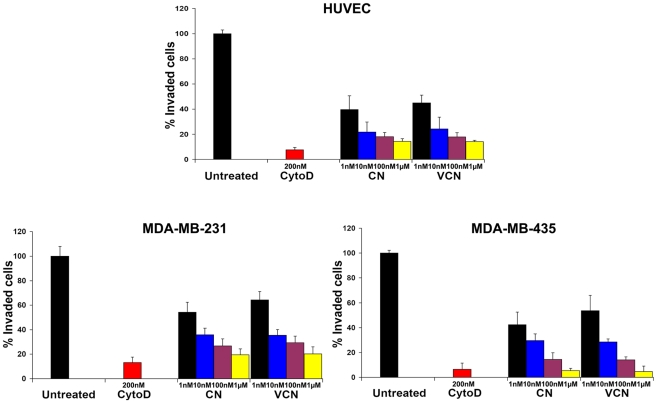
VCN inhibits cell invasion through a reconstituted basement membrane in a dose-dependent manner.The anti-invasive properties of VCN were tested in a modified Boyden chamber assay where serum-starved HUVEC, MDA-MB-231 or MDA-MB-435 cells were preincubated with various concentrations of disintegrins (1–1000 nM) for 10 min before being seeded into Matrigel-coated (ECMatrix™, Millipore) porous inserts (pore size, 8 µm) and allowed to invade against a chemoattractant gradient (HT1080 human fibrosarcoma conditioned media) for up to 48 hr. The fungal metabolite Cytochalasin D, a potent inhibitor of actin polymerization, was used as a positive control at a concentration of 200 nM. The above data were averaged from three independent experiments for each cell line tested.